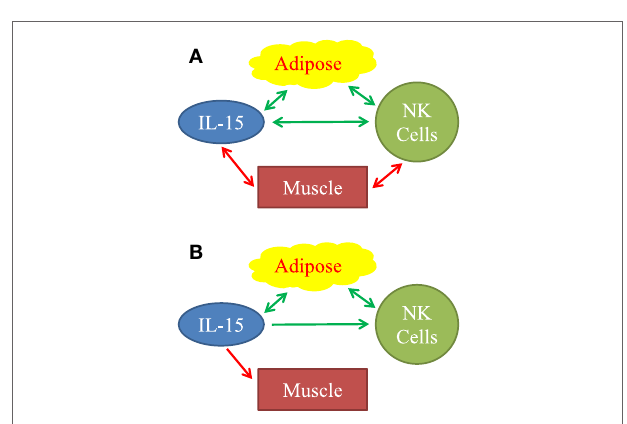
FigUre 7 | Observed associations (a) and proposed mechanistic relationships (B) between adipose tissue, IL-15, natural killer (NK) cells, and muscle. (a) Positive associations are represented by green arrows. Inverse associations are represented by red arrows. All arrows are double-headed, indicating that associations do not necessarily imply mechanism. Mechanistic model (B) is based on our findings and on published literature. Stimulatory mechanisms are represented by green arrows and inhibitory mechanisms are represented by the red arrow. Double-headed green arrows indicate mutually positive stimulation. We propose that adipose tissue is a significant source of IL-15, especially in aging humans. IL-15 stimulates NK cells. Importantly, IL-15 forms part of a positive feedback loop between adipose tissue NK cells, other type 1 innate lymphocytes, and macrophages, as represented by the double-headed green arrows. IL-15 and other inflammatory agents weaken muscle.